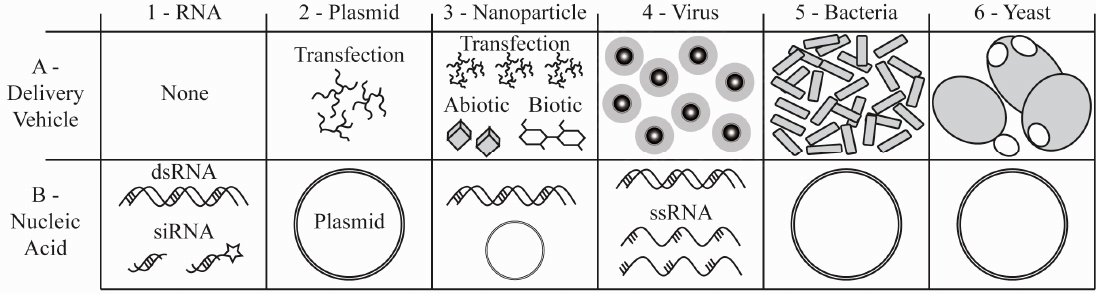
Figure 2. Diverse examples of mosquito RNAi trigger delivery systems (see also Table 2). The variety of ( A ) delivery vehicles and ( B ) RNAi trigger producing nucleic acids employed to suppress genes in mosquito species. Examples shown include: ( 1 ) naked RNAi triggers such as dsRNA, siRNA, or chemically modified siRNA (star shape); ( 2 ) transfection agents with dsRNA or shRNA expressing plasmids; ( 3 ) nanoparticles of abiotic or biotic origin in combination with dsRNA or plasmids; ( 4 ) viral expression systems carrying dsRNA or ssRNA that is converted to dsRNA in the cell; ( 5 ) bacterial expression systems containing dsRNA or shRNA plasmids; and ( 6 ) yeast expression systems containing dsRNA or shRNA plasmids. Numerals in the figure correspond to Section 3 of the text and Table